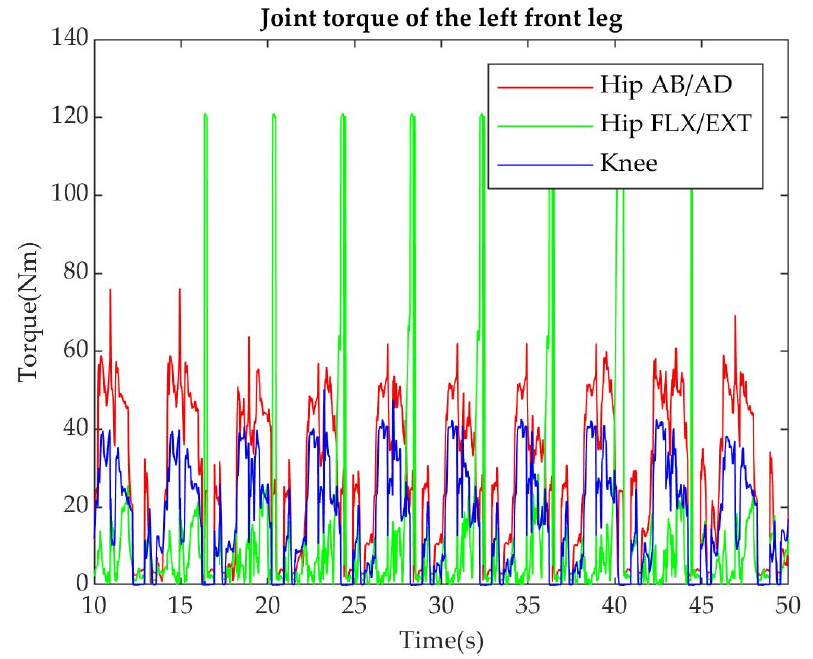
Figure 27. Joint torque of the left front leg. Most of the time, the output torque of the actuator is within the recommended range. When climbing the stairs, hip FLX/EXT actuator periodically outputs maximum torque for short periods of time.